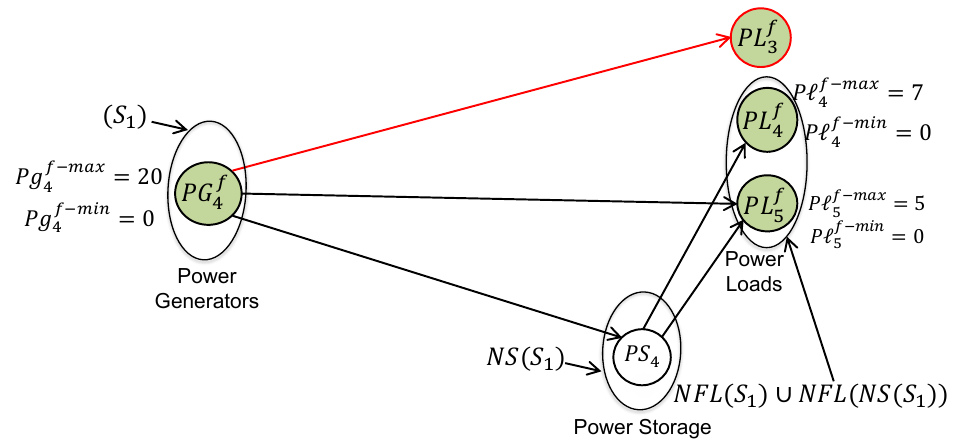
Figure 22. One possible new connection (red line) for including new power load into NFL ( S 1 ) ∪ NFL ( NS ( S 1 ))